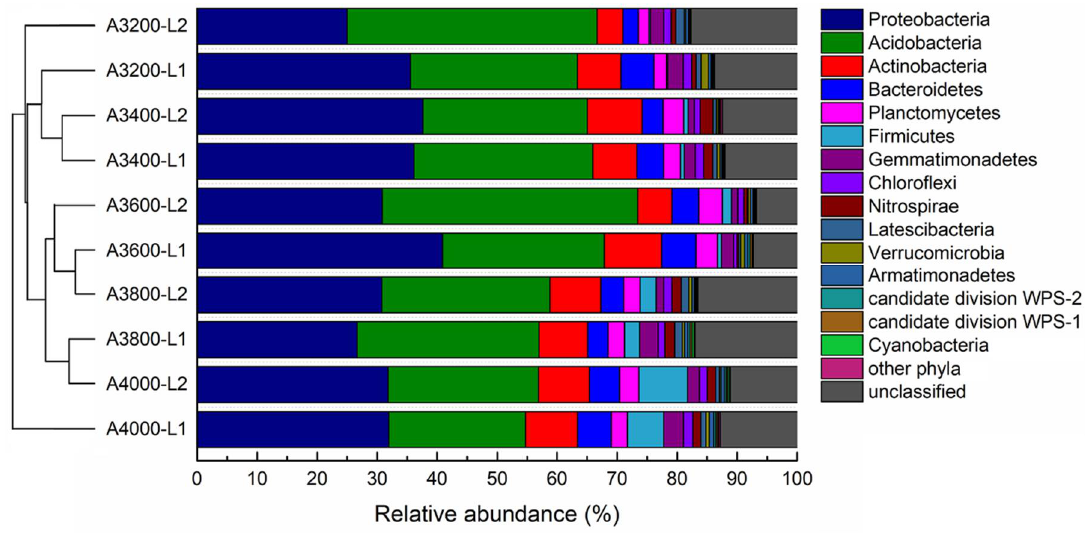
Figure 4. Relative abundance of soil microbes at each altitude and in each soil layer at the phylum level. At the phylum level, the dominant phyla among all of the soil samples were Proteobac- teria (32.7%), Acidobacteria (30.2%) and Actinobacteria (7.7%), followed by Bacteroidetes (4.4%), Planctomycetes (2.9%), Firmicutes (2.3%), Gemmatimonadetes (2.0%), Chloroflexi , (1.2%), and Nitrospirae (1.2%). The sum of the relative abundances of other identified phyla was 2.5%, and the remaining 12.8% was unclassified. Two-way ANOVA showed that soil depth had significant ( p < 0.05) impacts on the relative abundances of Gemmatimonadetes and Verrucomicrobia , and altitude had significant ( p < 0.05) impacts on the relative abun- dances of Planctomycetes , Firmicutes , Gemmatimonadetes , Nitrospirae , Latescibacteria and Ar- matimonadetes . At the genus level, 44 genera had an average relative abundance of more than 0.1%, and the relative abundance of all of the unclassified OTUs was 80.7%. The top 10 genera in relative abundance were Gemmatimonas (2.0%), Gaiella (1.4%), Bradyrhizobium (1.3%), Nitrospira (1.0%), Variovorax (1.0%), Steroidobacter (0.9%), Arthrobacter (0.5%), Pedomicro- bium (0.4%), Solirubrobacter (0.4%), and Arenimonas (0.3%). Two-way ANOVA showed that soil depth had significant ( p < 0.01) impacts on the relative abundance of Gemmatimonas , and altitude had significant ( p < 0.05) impacts on the relative abundances of Gemmatimo- nas , Gaiella , Bradyrhizobium , Nitrospira and Steroidobacter. 3.4. Diversity Indices of Soil Microbial Communities The total reads, number of OTU taxa, and diversity indices of the soil microbial com- munities are shown in Table 3. The mean values of all of the indices in the topsoil were higher than those in the subsoil, although two-way ANOVA showed that only the differ- ences in the number of OTU taxa between the two soil layers reached a significant level ( p < 0.05). The altitude had different impacts on the soil microbial communities in the two soil layers. The total reads, the number of OTU taxa, and the Chao1 at A3200 were highest in the topsoil but lowest in the subsoil. In the topsoil, microbial evenness (Pielou) and diversity (Shannon and Simpson) were moderate at A3200, relatively low at A3400 and A3800, and relatively high at A3600 and A4000. In the subsoil, the microbial evenness and diversity were relatively low at A3200 and A3600, highest at A3400, and moderate at A3800 and A4000. Table 3. Total reads, number of OTU taxa and diversity indices of soil microbial communities.